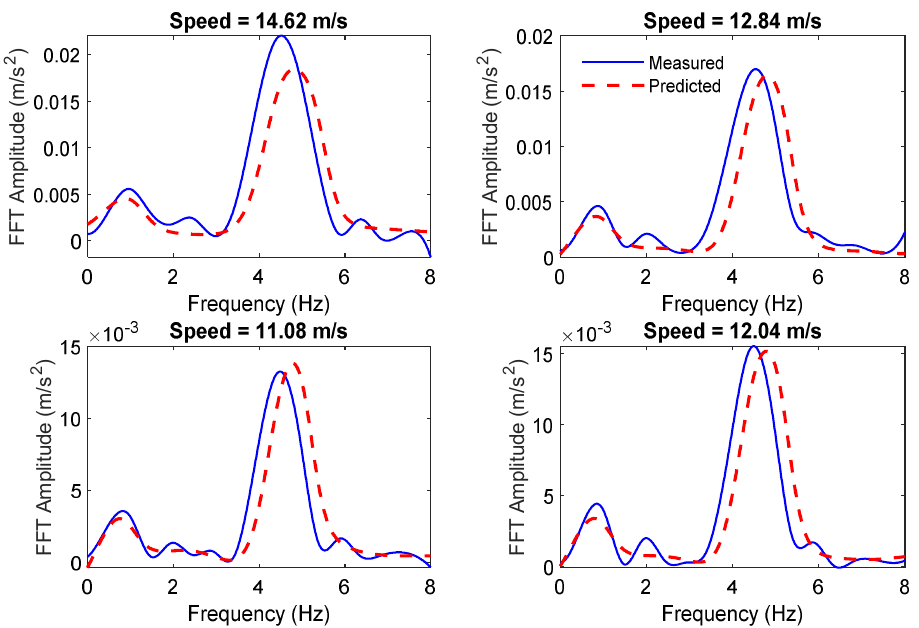
Figure 12. The comparison of the predicted and measured vehicle FFT responses over the damaged bridge with a crack ratio of 0.3.